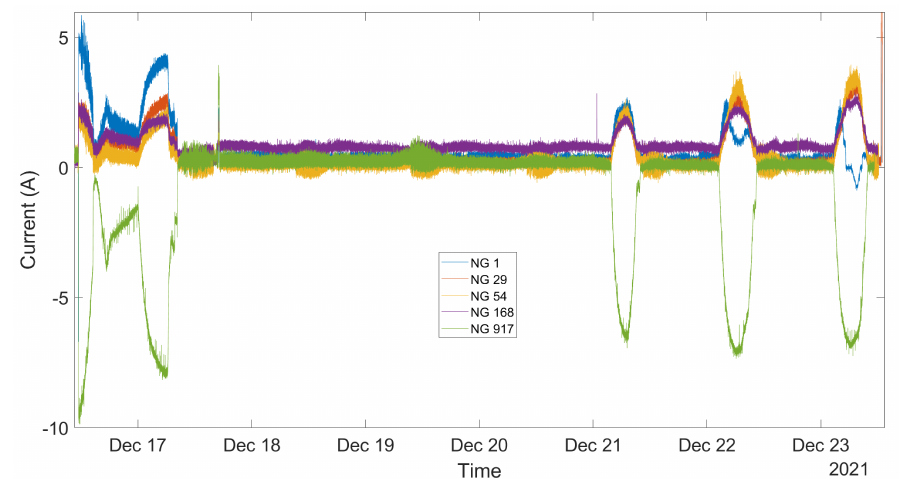
Figure 30. Exchanged currents on the microgrid deployed in